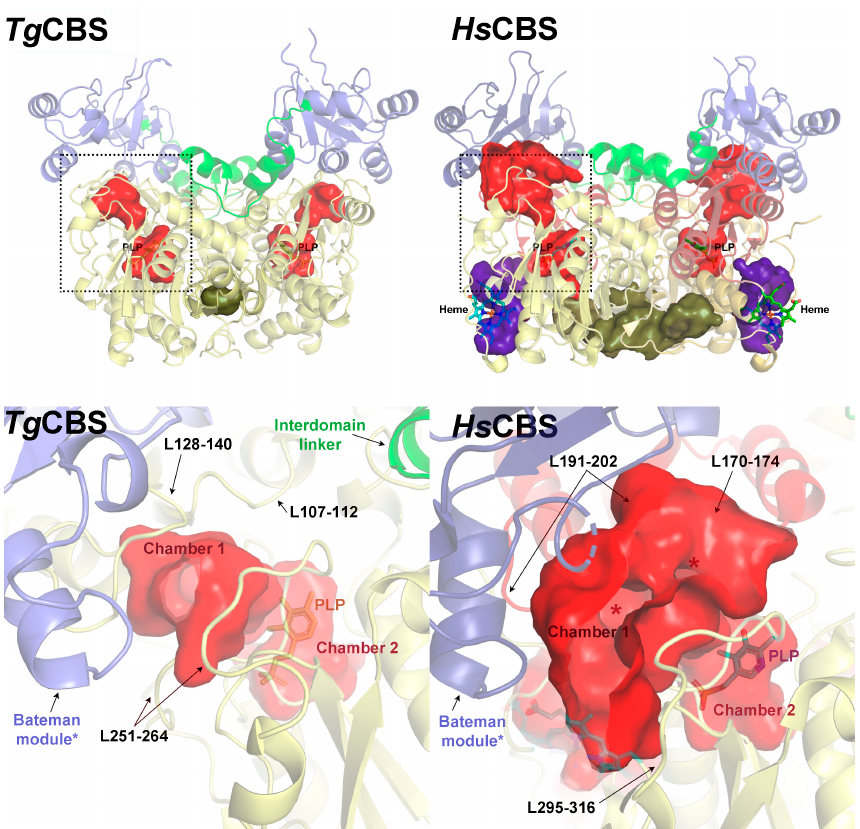
Figure 7. Catalytic cavity of TgCBS and HsCBS. The picture shows the main structural elements defining the entrance of the catalytic cavity in TgCBS ( left ) and HsCBS ( right ). The location of the main cavities within the corresponding CBS basket-like protein dimers are framed in dotted lines and zoomed up in the lower panels. The complementary catalytic cores, interdomain linkers and Bateman modules are represented by yellow , green, and dark blue ribbons, respectively. The interior surfaces are colored ( red for the catalytic cavity, green for the intersubunit cavity, and violet for the heme-binding cavity (the latter is absent in TgCBS as the native protein lacks a heme-binding domain). The different entries into the first chamber of the catalytic cavity, which is exposed to the solvent, are indicated with asterisks. Chamber-2, located underneath and connected to Chamber-1, is deeply buried in the protein core and hosts the PLP cofactor (in sticks).